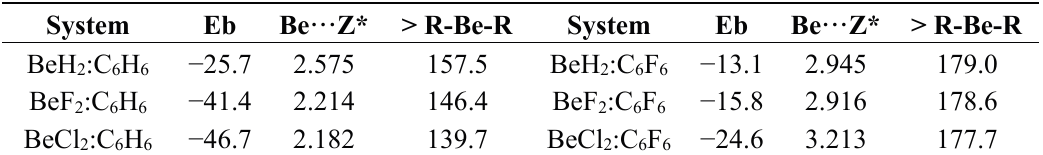
(°) of the BeR 2 :C 6 X 6 binary